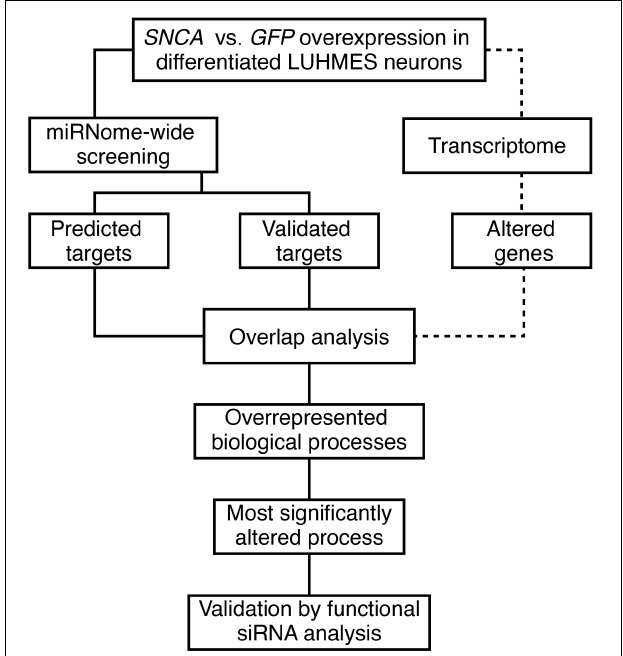
FIGURE 1 | Overview of the study workflow. An in vitro SNCA overexpression model of α Syn-related pathology compared to a GFP-control model served as basis for the identification and analysis of miRNA target